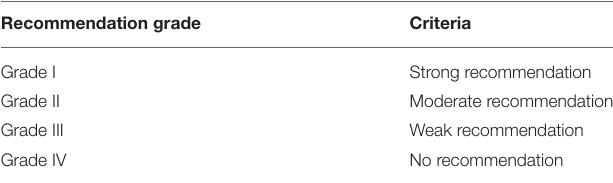
TABLE 2 | Recommendation grades for this current expert